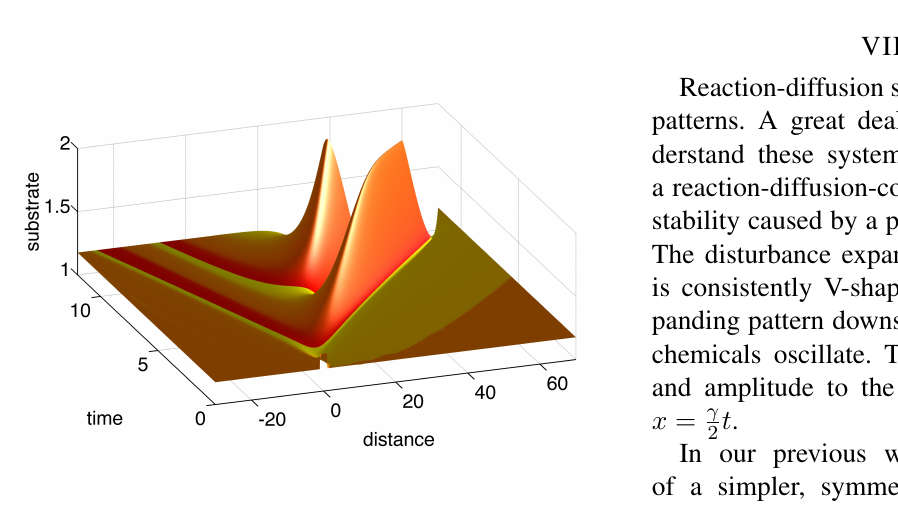
Figure 4. The θ behaviour (colour map) shows a broad propagation of pattern. However, the instability ( r > 0 , z -axis) does not propagate so widely. We see that the instability is only present for half of the underlying behaviour. The left wavefront is actually at the centre of the pattern, the line traced out from the initial disturbance. The parameters here are ε = 1 . 0 , γ = 5 . 0 , µ = 0 . 85 . This is a numerical solution of the original Schnakenberg reaction-diffusion-convection equation (2) using NAG D03PCF. The reactants are initially at steady state: ( u, v ) = (0 , 0) , with a small disturbance at x = 0 . The boundaries are held at zero derivative: u x = 0 , v x = 0